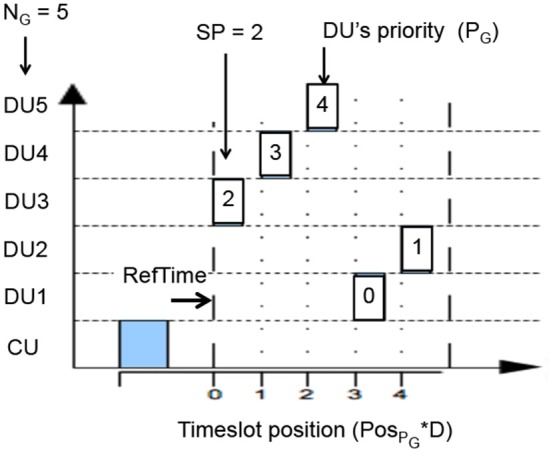
Schematic representation of STIMAP TDMA.